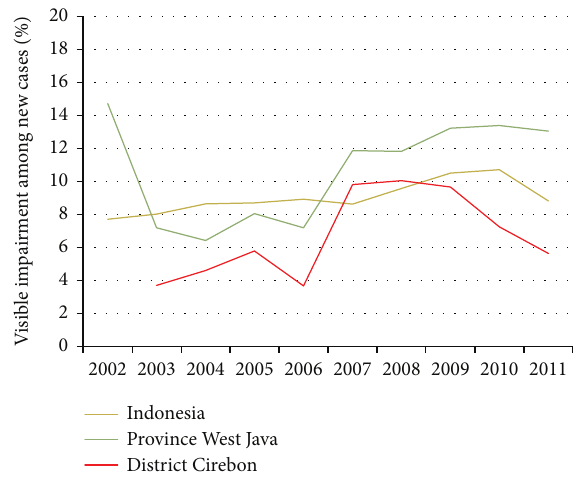
Figure 2: 10-year trend of % visible impairments among new cases in Indonesia, West Java and Cirebon in 2002–2011 (data is merged from [21, 22]).